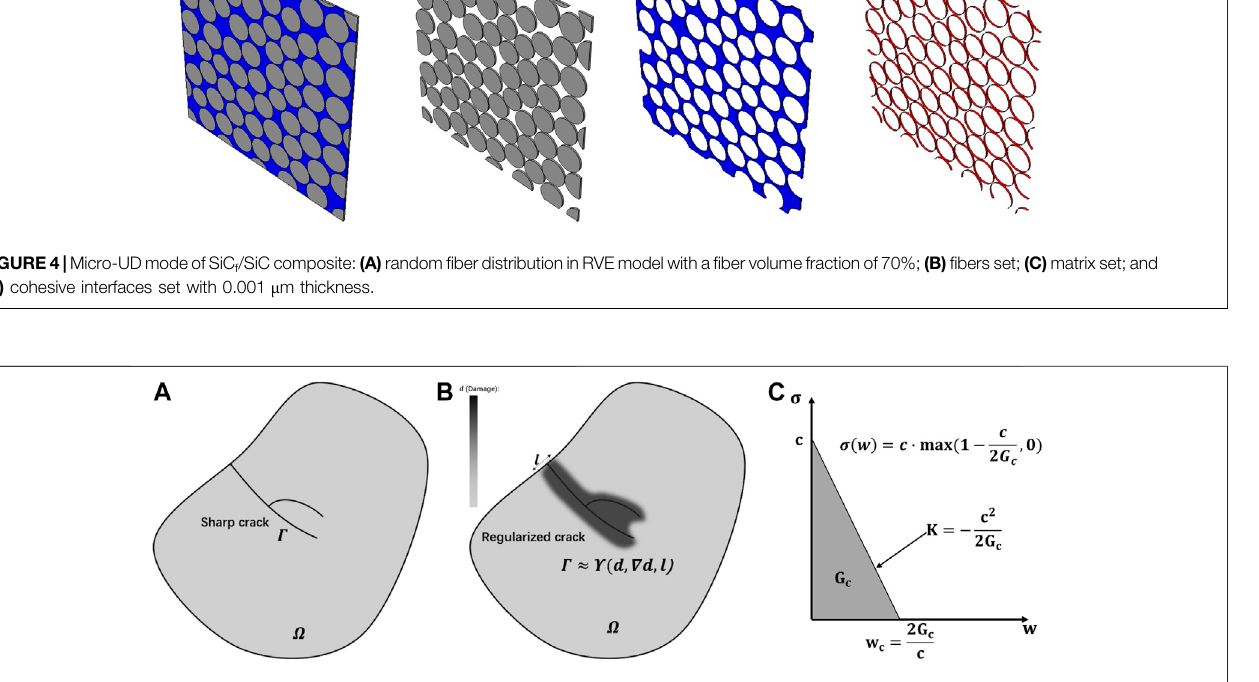
FIGURE 5 | A solid medium with a sharp crack (A) and the phase- fi eld regularization (B) , and (C) illustrates the linear traction-separation law during crack propagation.